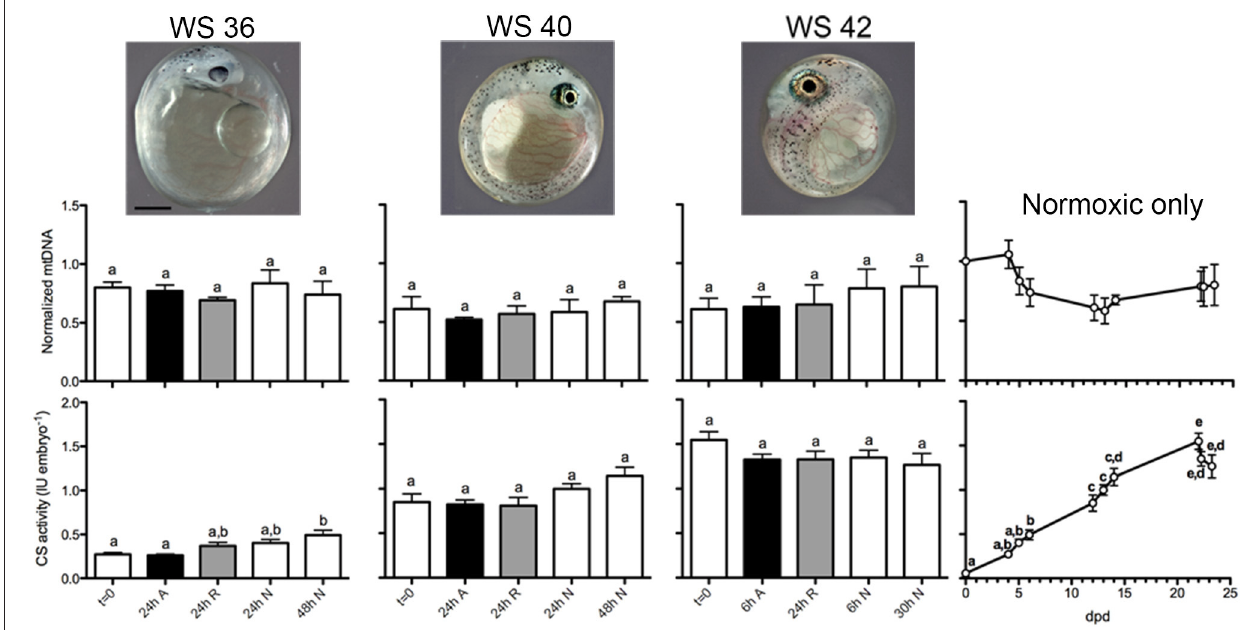
FIGURE 12 | Relative mtDNA copy number and total CS activity and across development and after anoxia/reoxygenation. There are no statistically significant differences in relative mtDNA copy number across development or treatment (top graphs). For the CS assays (bottom graphs), different letters above bar graphs correspond to levels of total CS activity that are significantly different within each stage (one-way ANOVA with Tukey’s MCT, P < 0.05). For the normoxia-only CS line graph data across development, different letters above data points correspond to levels of total CS activity that are significantly different between stages (one-way ANOVA with Tukey’s MCT, P < 0.05). Embryo photos are from Riggs and Podrabsky, unpublished. Scale bar is 0.5mm for the embryo